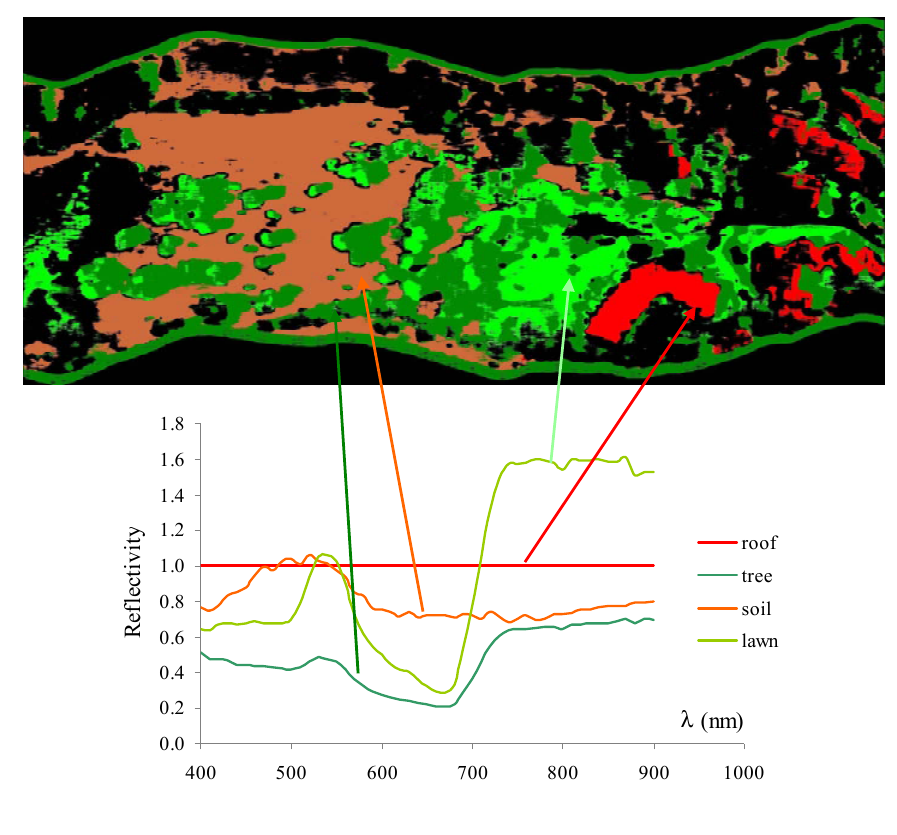
Figure 17. Map of the investigated area and spectral